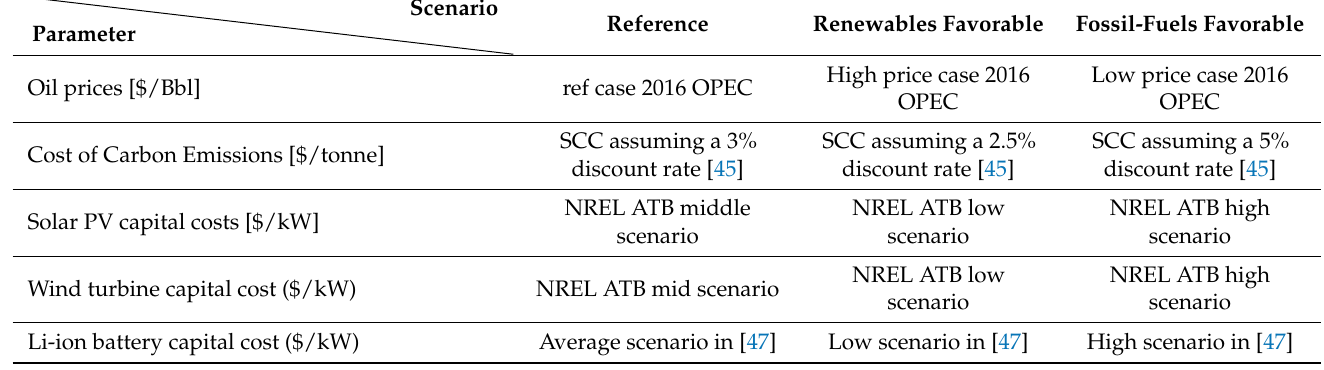
Table 4. Scenarios to explore the sensitivity of results to assumptions on fuel prices, cost and performance of electricity generation technologies, and cost of carbon dioxide emissions.